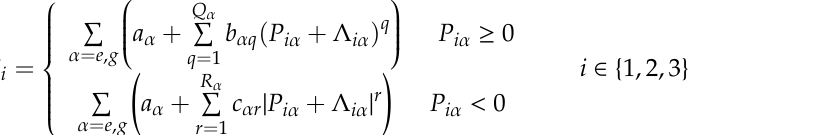
Figure 3. Simplified structural diagram of the multi-energy hub system.